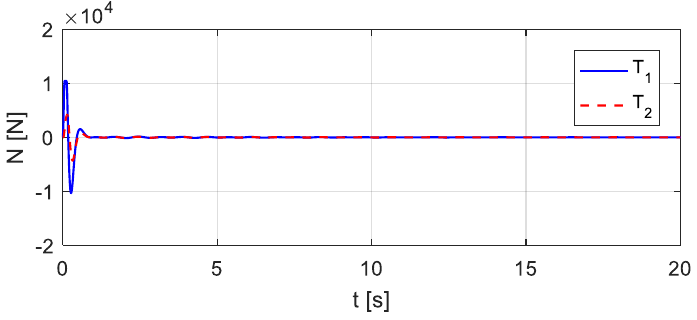
Figure 20. Estimated time histories of the excitations at wheels T 1 and T 2 in case wheel T 1 bumps.